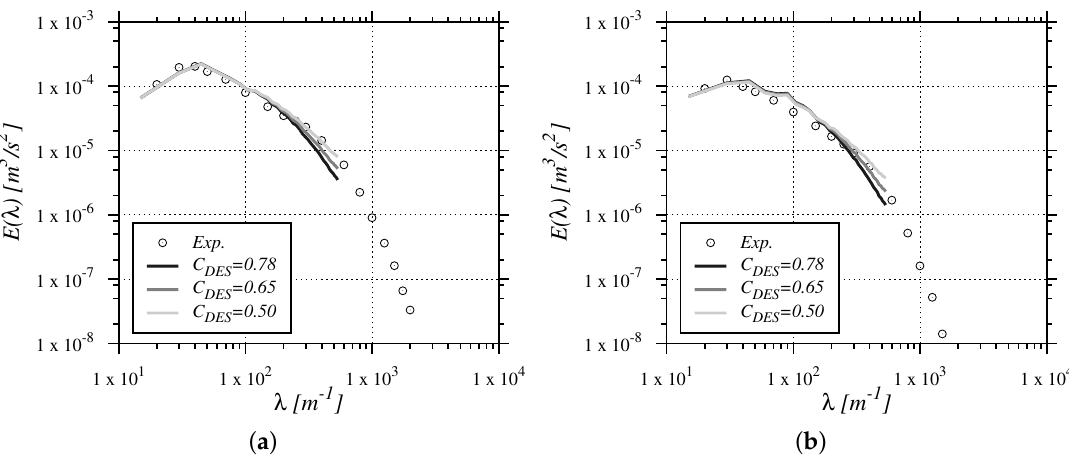
Figure 1. Three-dimensional energy spectra obtained with the pure LES mode of the RNG k – ε model, for different C values: ( a ) t = t 1 ; ( b ) t = t 2 . DES